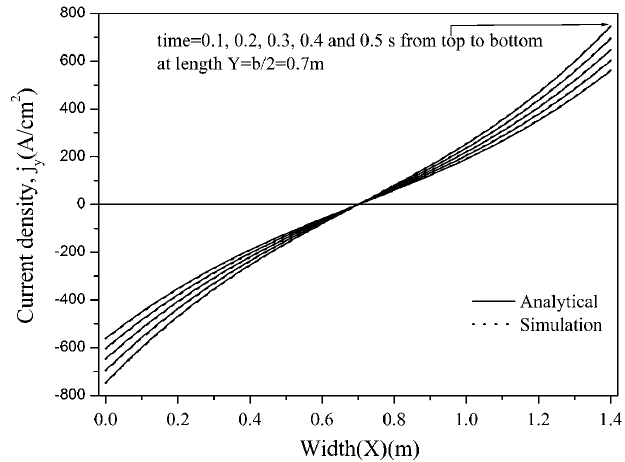
ð A = cm 2 Þ in y